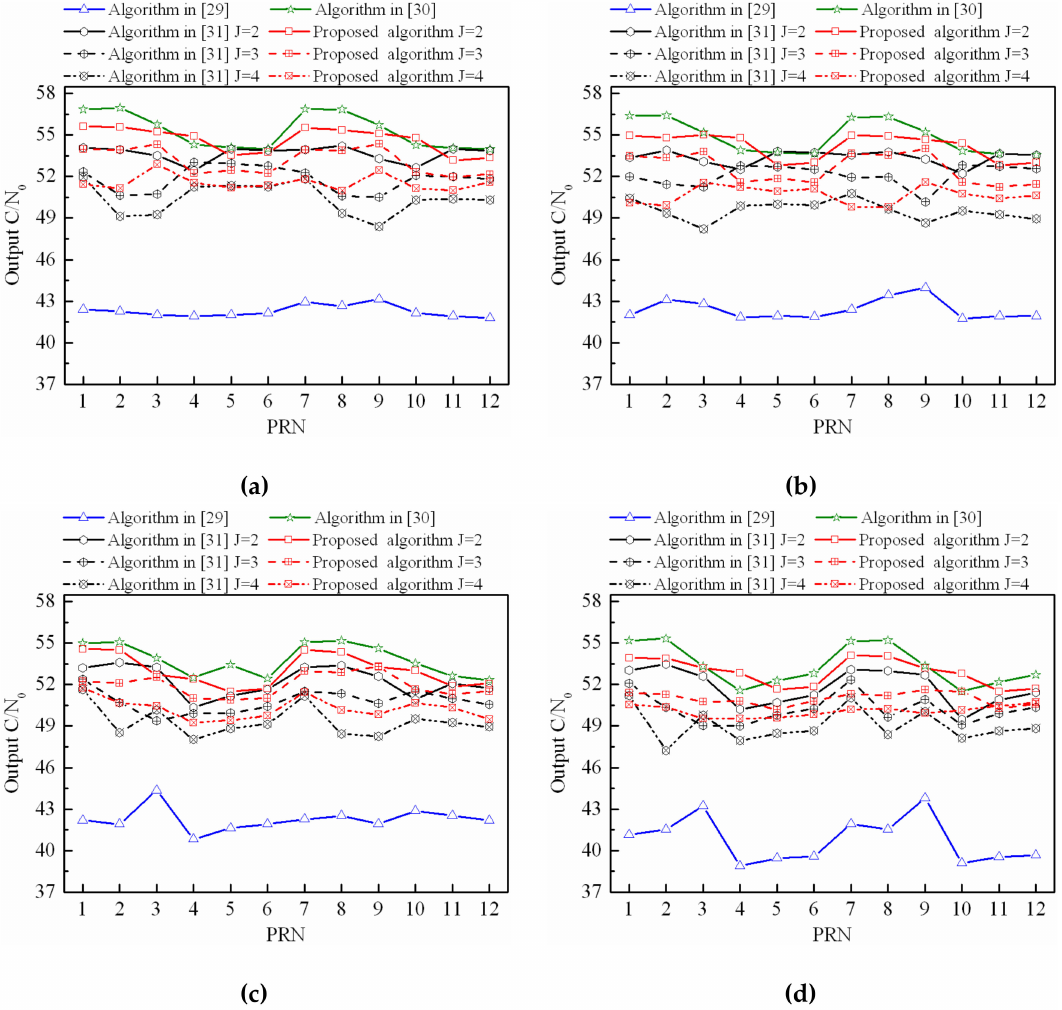
Figure 11. Output C/N 0 performance comparison between the proposed STPAP algorithm and the STPAP algorithms based on the criterions in [29–31] when there are interferences with the same polarization mode: ( a ) one interference; ( b ) two interferences; ( c ) three